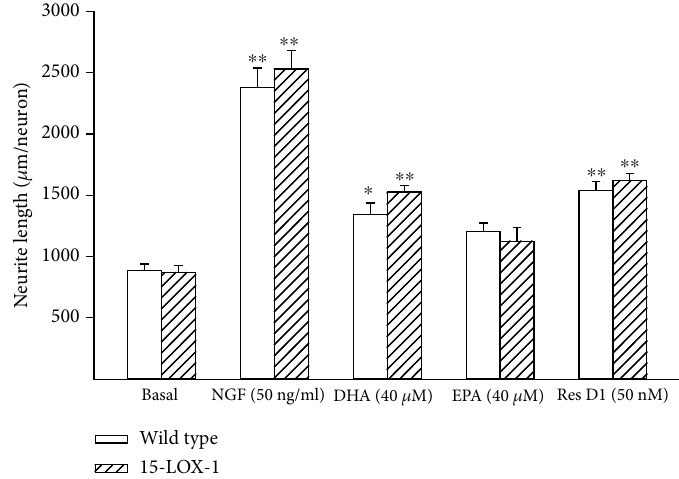
Figure 6: E ff ects of nerve growth factor (NGF), docosahexaenoic acid (DHA), eicosapentaenoic acid (EPA), or resolvin D1 (50 nM) on neurite growth by dorsal root ganglion neurons derived from wild-type and 15-LOX-1 transgenic mice. Dorsal root ganglion neurons were collected and cultured as described in Section 2. Afterwards, the e ff ects of nerve growth factor (50 ng/ml), docosahexaenoic acid (40 μ M), eicosapentaenoic acid (40 μ M), or resolvin D1 (50 nM) on neurite outgrowth were determined. Data are presented as the mean ± SEM in μ m per neuron. The number of mice used per group ranged from 10 to 12. ∗ p < 0 : 05 compared to their respective basal; ∗∗ p < 0 : 01 compared to their respective